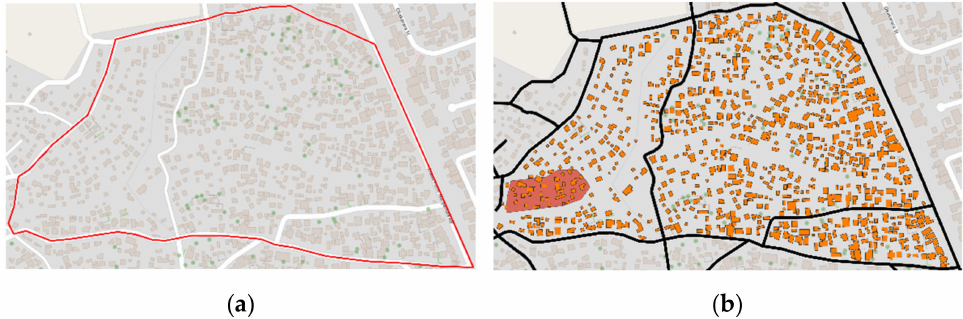
Figure 2. ( a ) Aerial view of the study area; ( b ) Method input data from OpenStreetMap [36]: shacks are represented as polygons (orange) and existing paths/roads are represented as line elements